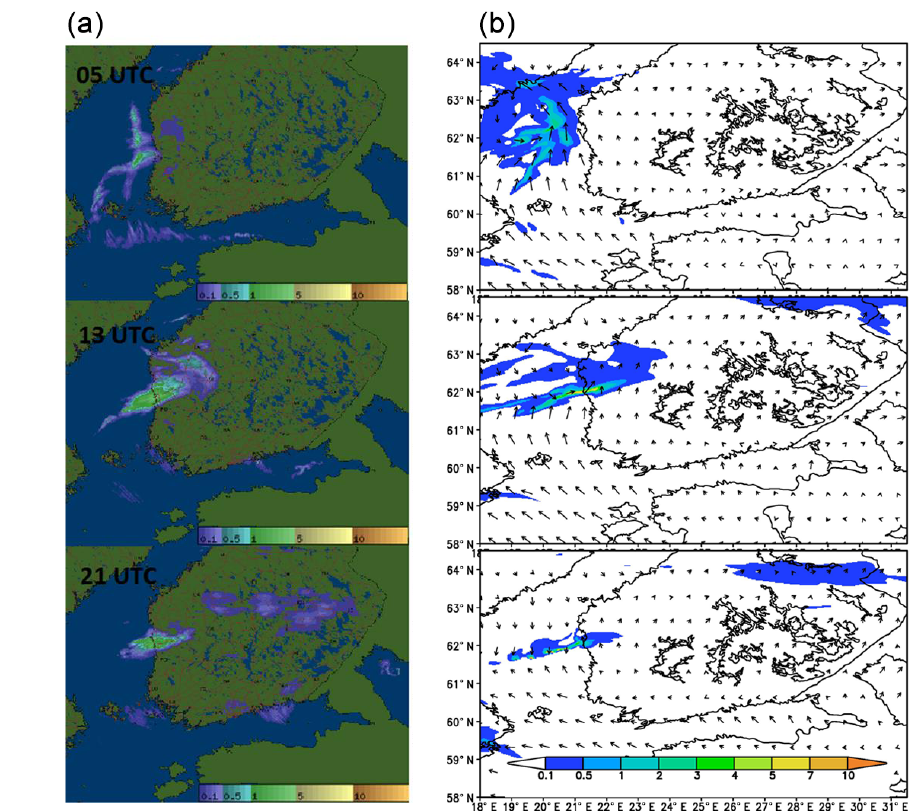
Figure 3. One-hour accumulated precipitation (mmh − 1 ) as observed by weather radar (a) and simulated with HARMONIE (b) for 05:00UTC (top panels), 13:00UTC (middle panels), and 21:00UTC (bottom panels) on 8 January 2016. Simulated wind field at 10m (arrows) is also shown. The latitudes and longitudes are given in the axes on the